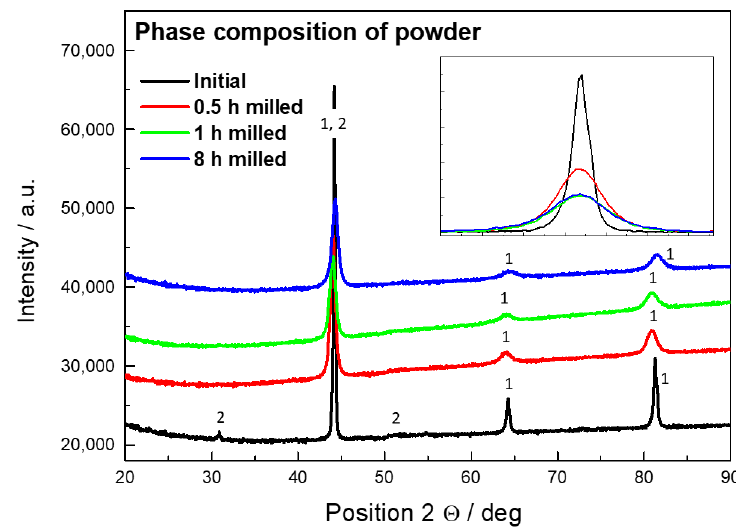
Figure 1. XRD pattern of Fe28Al powder in the initial state and after milling for 0.5, 1, and 8 h, 1—A2 FeAl, 2—B2 FeAl.